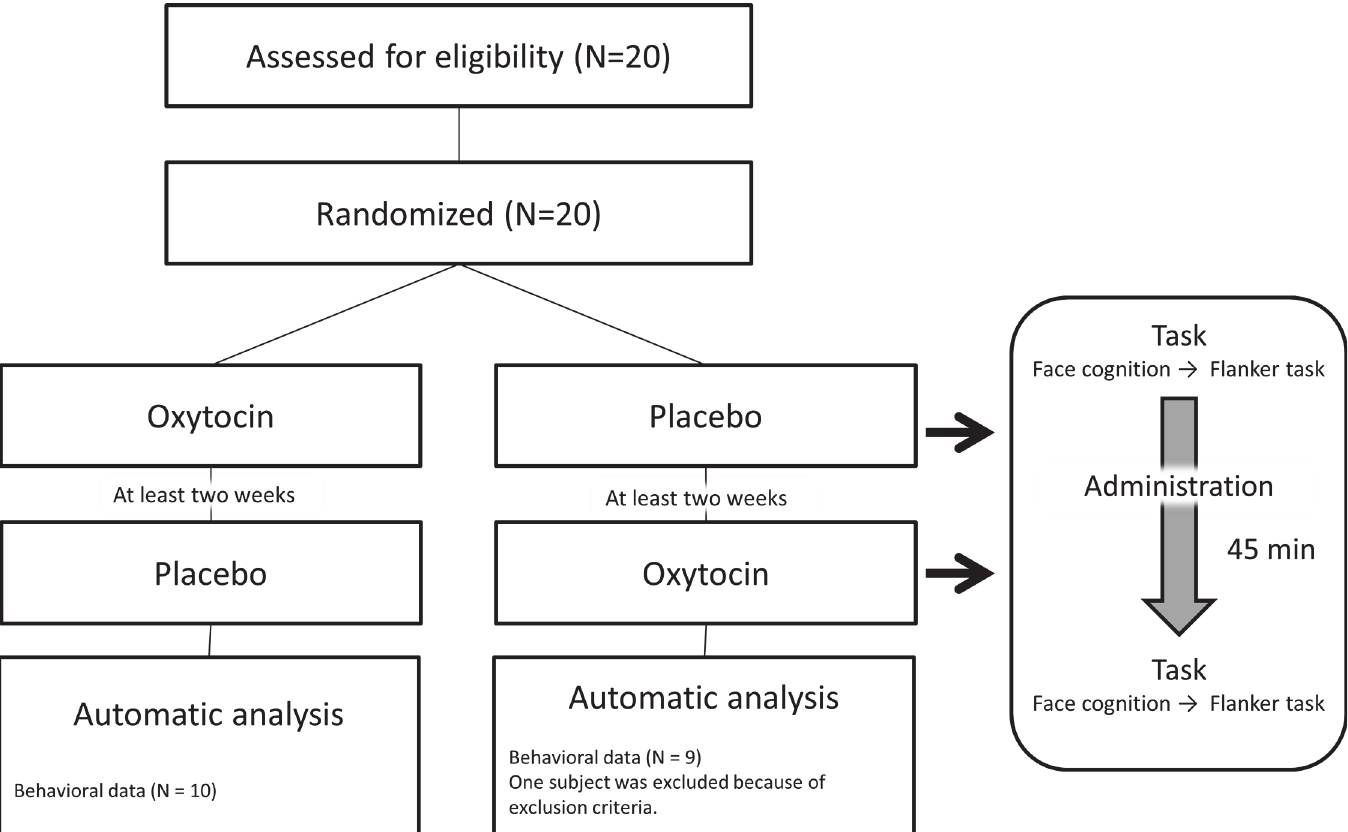
Fig 1. Study design. Twenty recruited participants were randomly assigned to receive either OT or placebo during the first trial. After an interval of at least 2 weeks, the second trial was conducted. The order of the two conditions (i.e., OT or placebo) was counterbalanced across subjects. Each experimental condition included two visual tasks (the interpretation of emotional facial expressions and the flanker task), and the participants conducted these different tasks twice under each condition (i.e., before and after administration). We excluded one subject from statistical analysis because of the exclusion